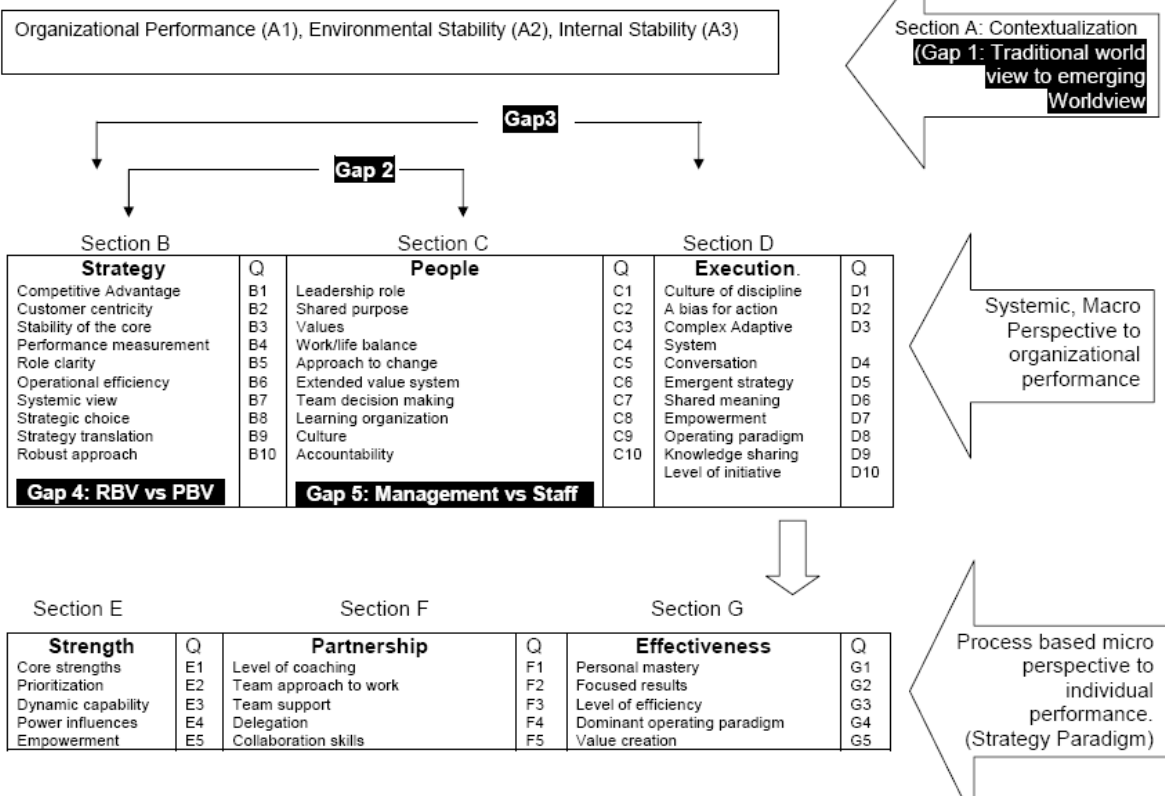
Figure 3: Structure of the Performance ESP